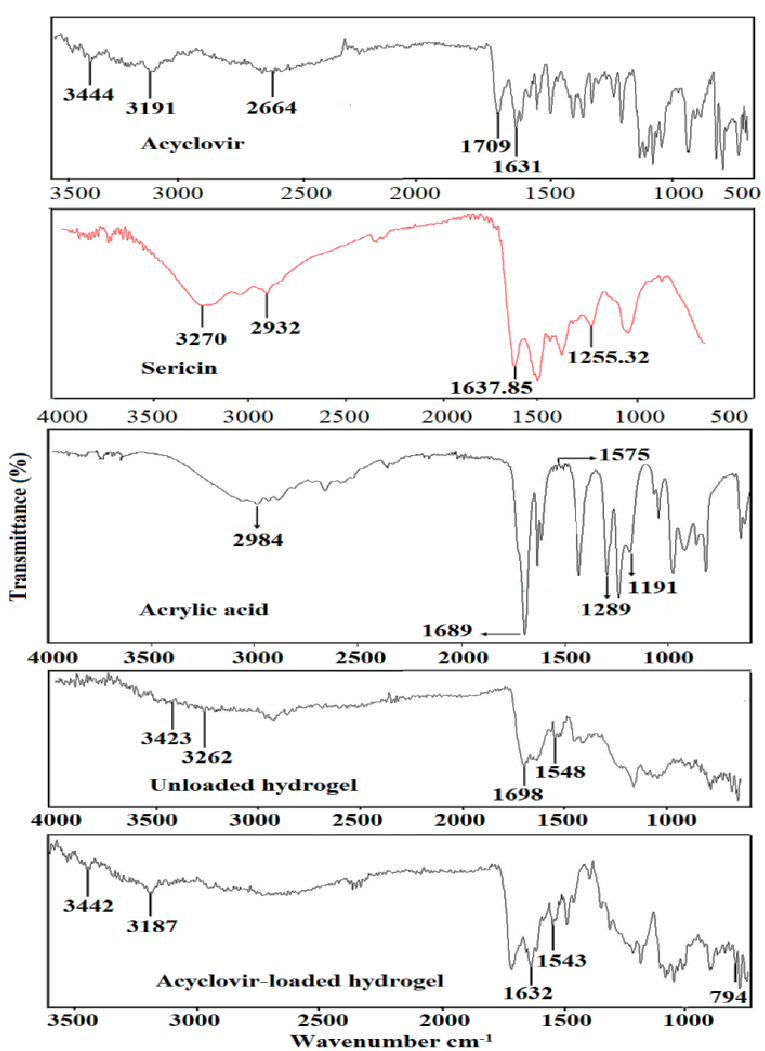
Figure 7. FTIR spectral graphs of Acyclovir, Sericin, AA, Unloaded hydrogel, and ACY-loaded hydrogel.